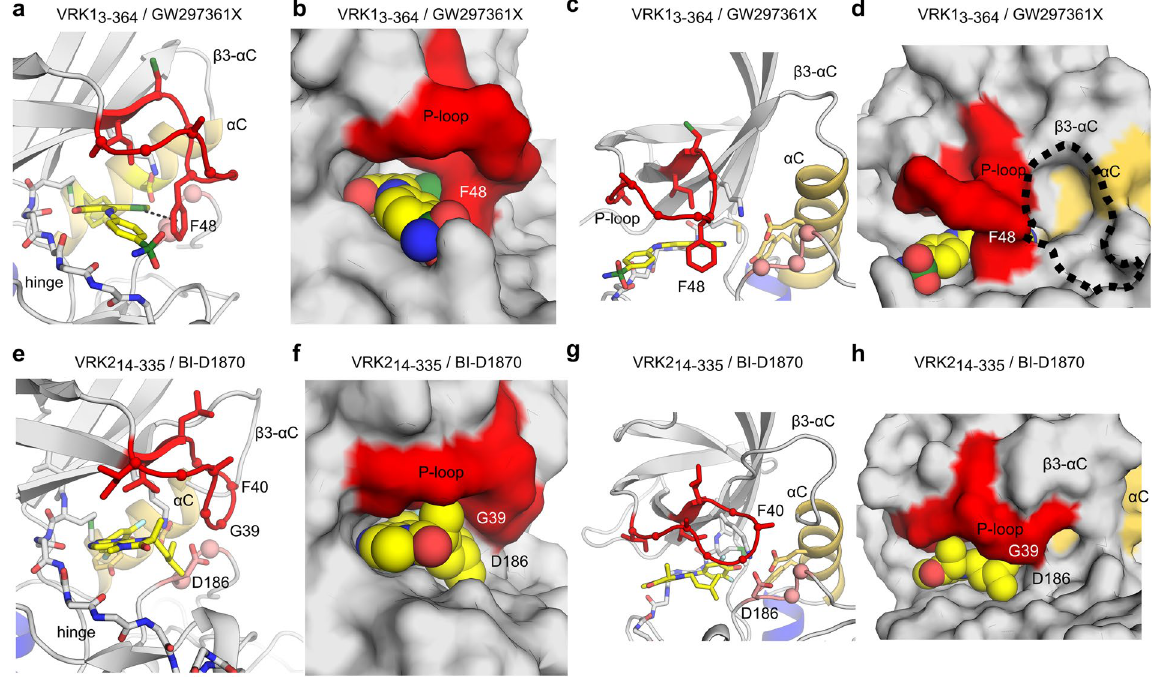
Figure 4. Ligand-induced, P-loop-folded conformation in active VRKs. ( a , c ) Cartoon and ( b , d ) surface representations of the P-loop region in VRK1 3-364 /GW297361X co-crystal. Dashed line in panel a indicates a sulfur- π interaction between the sulfur atom in the thiazole ring from the ligand and P-loop residue Phe48. Dashed line in panel d indicates a cavity between α C and P-loop exclusive to VRK1. ( e , g ) Cartoon and ( f , h) surface representations of the P-loop region in VRK2 14–335 /BI-D1870. Views in ( a , b and e , f ) are rotated ~90° from those in ( c , d and g , h )